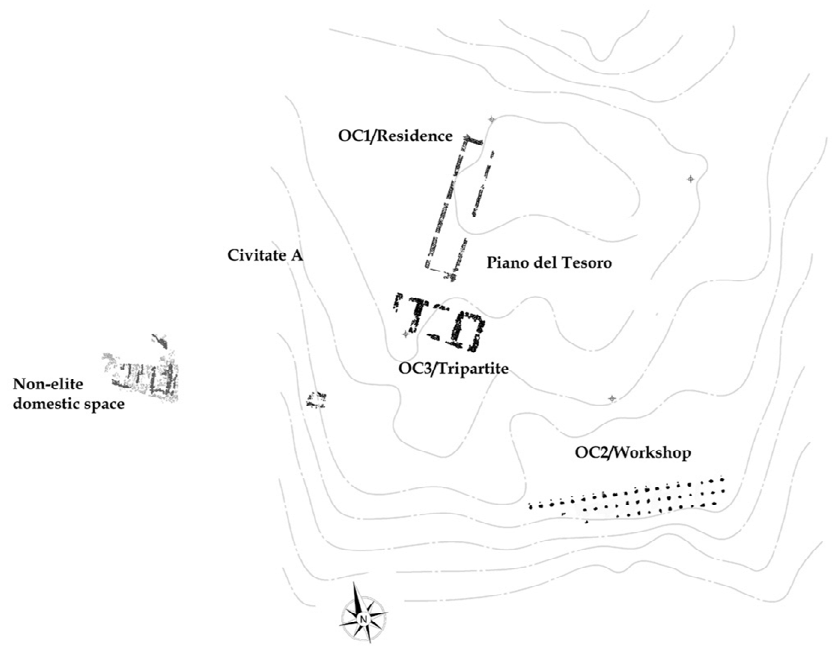
Figure 1. Site plan of the Orientalizing Phase architectural remains, dating to 675/650–600 BCE (Image: Poggio Civitate Project).